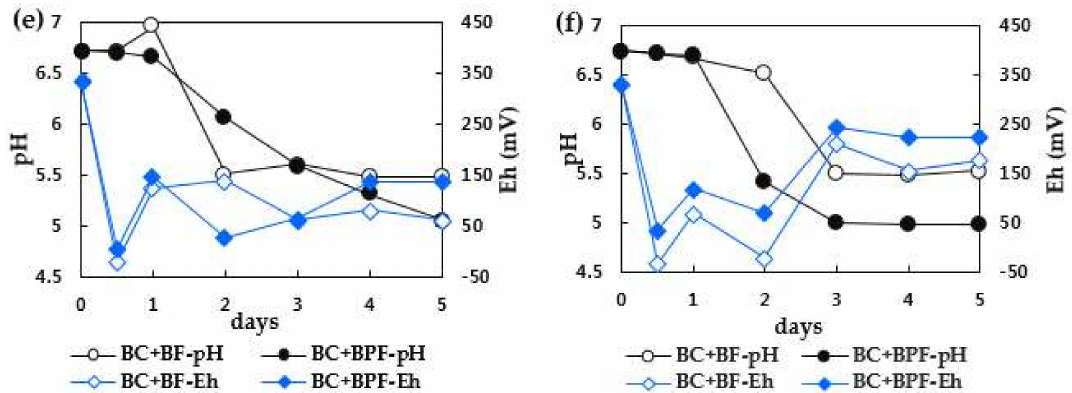
Figure 2. Changes in pH of ( a ) BC; ( c ) BF; open circle, BPF; closed circle ( e ) BC + BF; open circle,